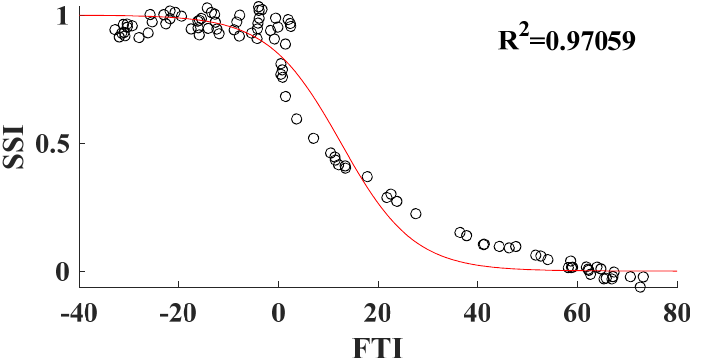
Figure 5. Scatters between SSI and FTI from simulation data. Black circles represent the simulation